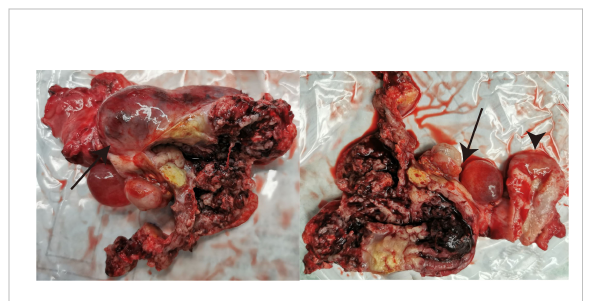
FIGURE 2 The gross view of the resected tumor originating from the bilateral ovaries (arrows) and uterus